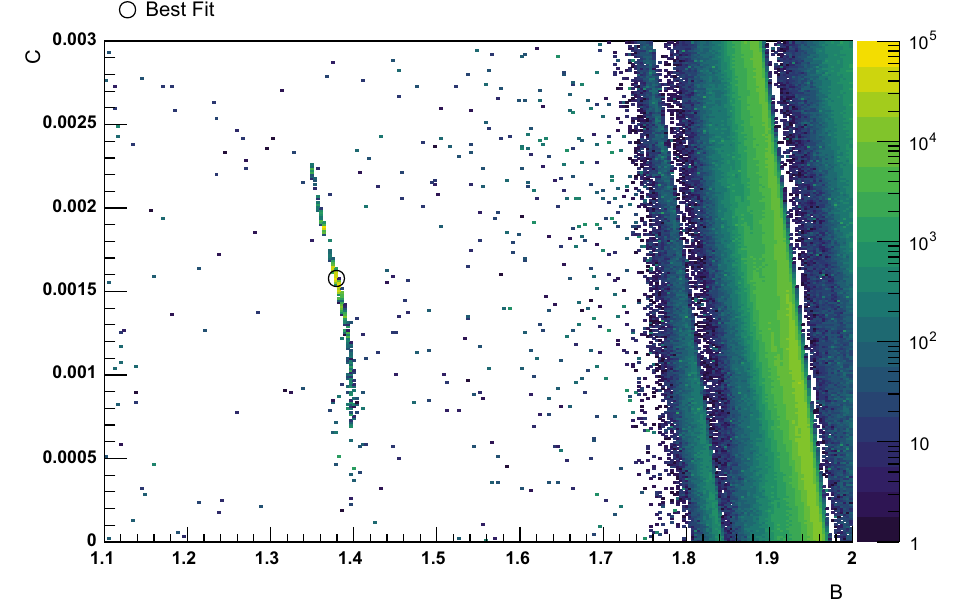
Fig. 5 Probability density of the ABC fit as a function of the B and C parameters. The legend shows the probability scale in arbitrary units